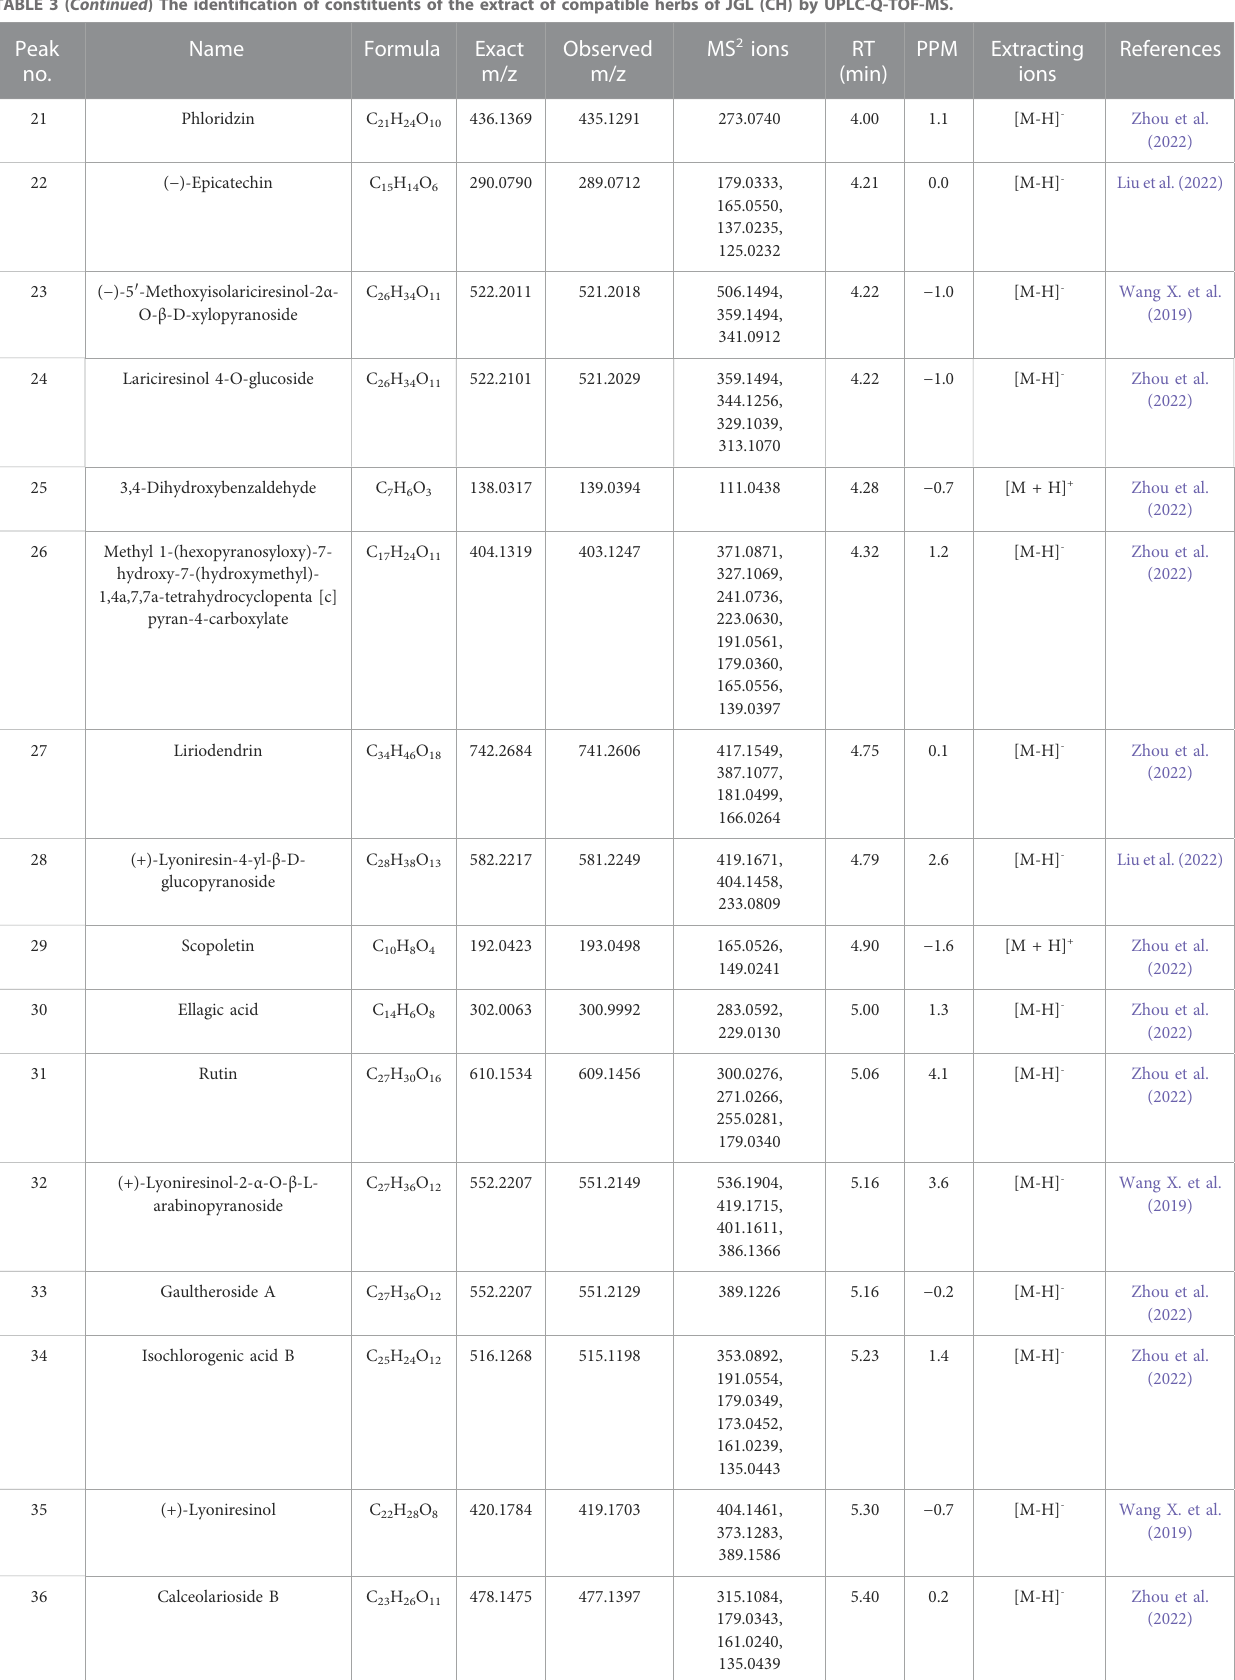
TABLE 3 ( Continued ) The identi fi cation of constituents of the extract of compatible herbs of JGL (CH) by UPLC-Q-TOF-MS. Peak